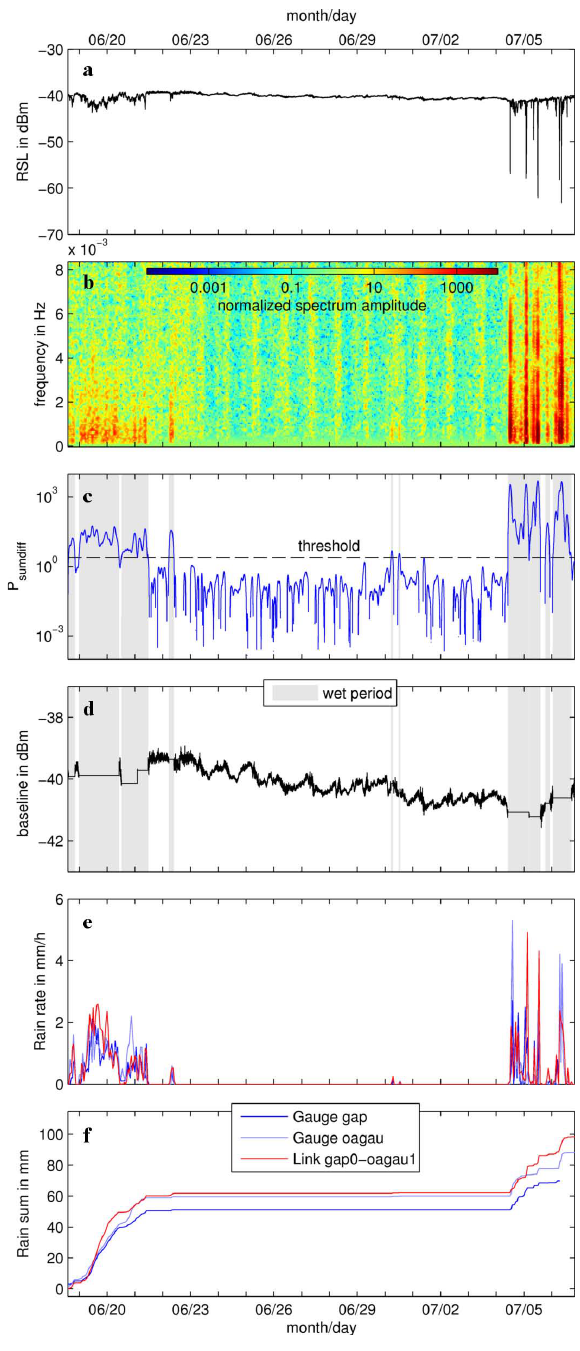
Fig. 4. Application of the proposed wet/dry classification algorithm to a 18-day RSL time series in summer 2010 from the link gap0- oagau1 . The plots from top to bottom show (a) the RSL time series, (b) its spectrogram, (c) the difference of the spectrum amplitude sums P sumdiff (see text for explanation), (d) the derived baseline for the RSL time series and (e) the calculated rain rates plus (f) the accumulated sum, both compared to two nearby rain